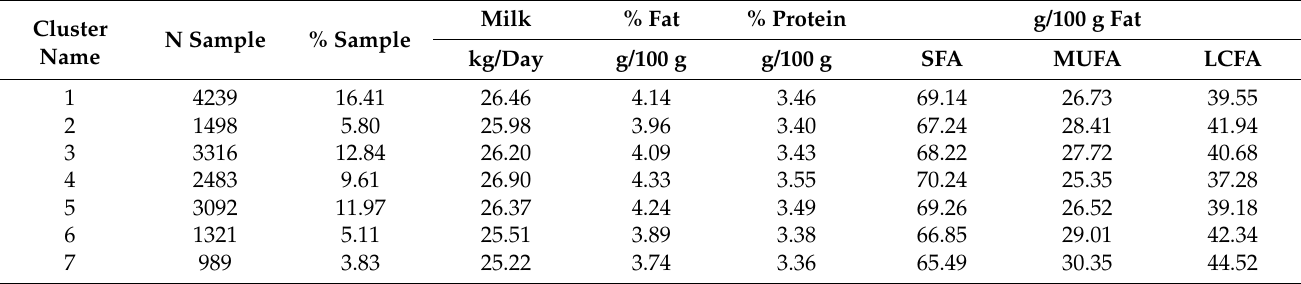
Figure 6. Dendrogram established from hierarchical clustering using the average monthly probability values for belonging to the GRASS1 cluster. Table 3. Descriptive statistics for the farm clustering (SFA = saturated fatty acids, MUFA = monoun- saturated fatty acids, and LCFA = long-chain fatty